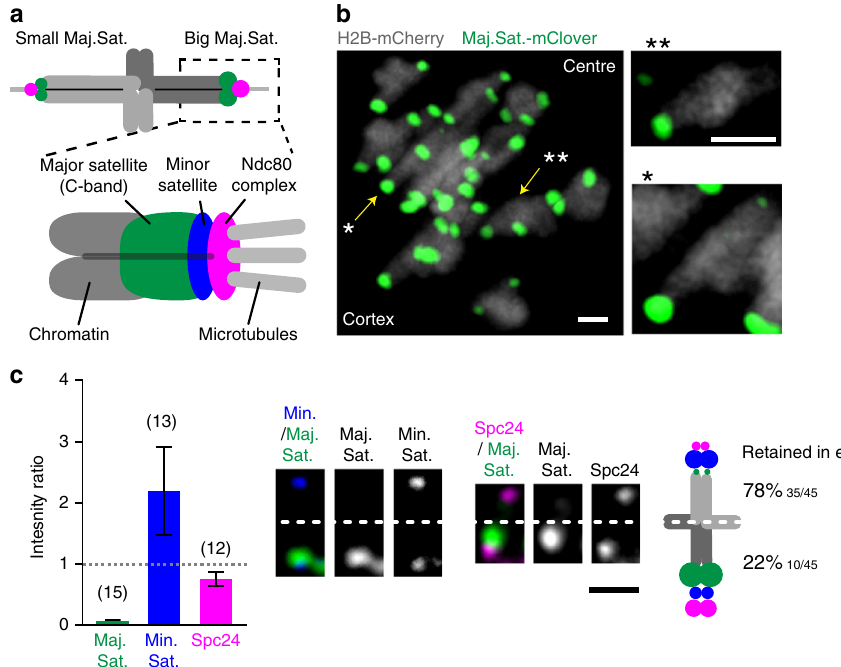
Fig. 1 Meiotic drive in C57Bl/6×SJL F 1 hybrid mice. a Schematic showing the location of the probes used (major satellite TALE, Maj.Sat.-mClover, green; minor satellite TALE, Min.Sat.-mRuby, blue; Spc24-mCherry, magenta; chromatin, H2B-mCherry, dark grey). b Z-projection of all bivalents within an oocyte, showing major satellite repeats (Maj.Sat.-mClover, green) and chromatin (H2B-mCherry, grey). Insets show both driving bivalents (identi fi ed by * and **) and, readily distinguished by their unique Maj.Sat. staining. c Intensity ratios for major satellite (green), minor satellite (blue) and Spc24 (magenta) signals on driving bivalent with extreme major satellite asymmetry. For each ratio, the bivalent half containing the larger major satellite repeat was the denominator. Representative images of these three regions are shown, oriented with the smaller major satellite repeat above the dotted line. The schematic displays the relative sizes of the major and minor satellites and Spc24 for each half of the bivalent, and the associated percentage retention in the egg. In parenthesis, number of bivalents examined, combined from three independent experiments. Error bars are 95% con fi dence intervals. b , c Scale bar is 2 µ